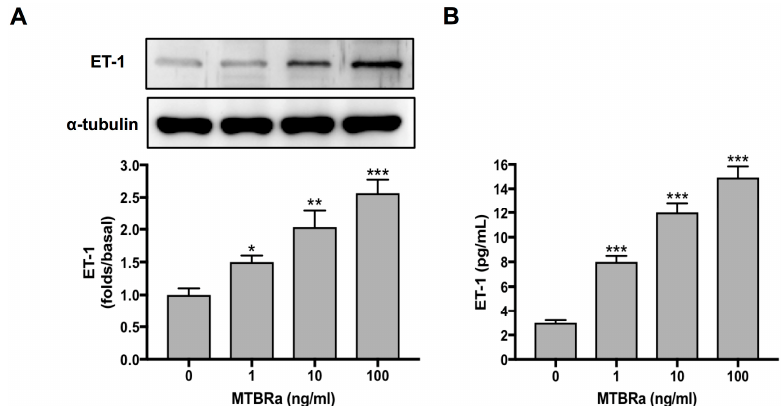
Figure 3. MTBRa induces ET-1 production in primary human PMCs. Cultured primary human PMCs (5 × 10 5 cells) were stimulated with the indicated concentrations of MTBRa for 24 h. ( A ) The total proteins from cell lysates were analyzed through Western blotting. ( B ) The levels of ET-1 in the culture supernatants were analyzed by ELISA. Data were shown as mean ± SD of three independent experiments. * p < 0.05, ** p < 0.01 and *** p < 0.001 compared with resting group. MTBRa, heat-killed Mycobacterium tuberculosis H37Ra; PMC, pleural mesothelial cell. J. Clin. Med. 2018 , 7 , x FOR PEER REVIEW